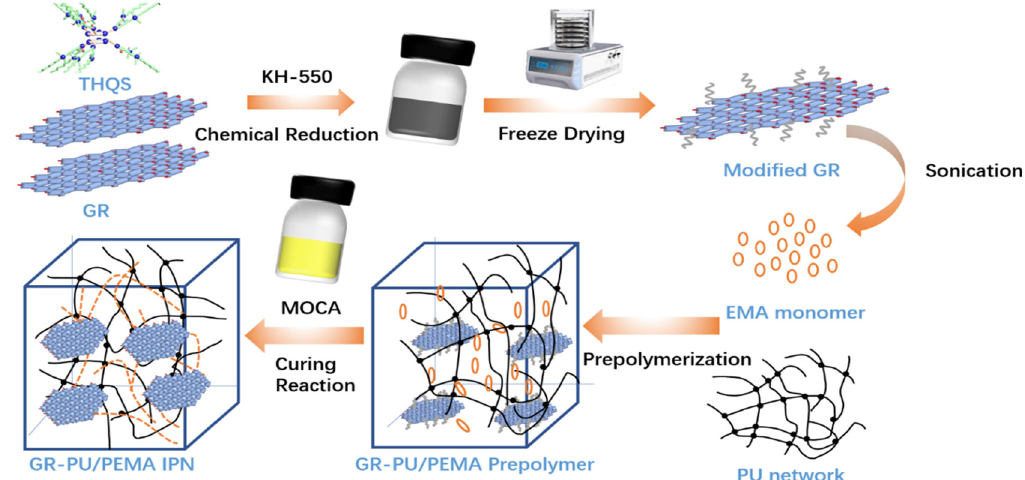
Figure 1: Schematic diagram for the synthesis of GR - PU/PEMA IPN damping